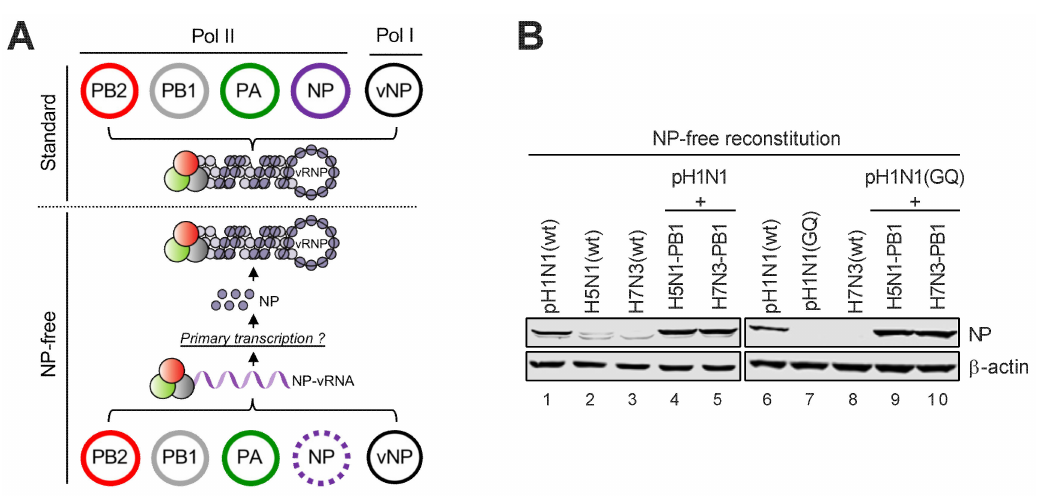
Figure 4. Avian-origin PB1 enhances viral primary transcription. ( A ) Schematic diagram of the NP-free reconstitution system. ( B ) 293T cells were co-transfected with three Pol II plasmids expressing polymerase (PB2, PB1, and PA) of indicated influenza A virus (IAV) strains along with a Pol I plasmid generating the full-length segment 5 viral RNA (vRNA) of pH1N1. The levels of NP protein expression were determined by immunoblotting at 24